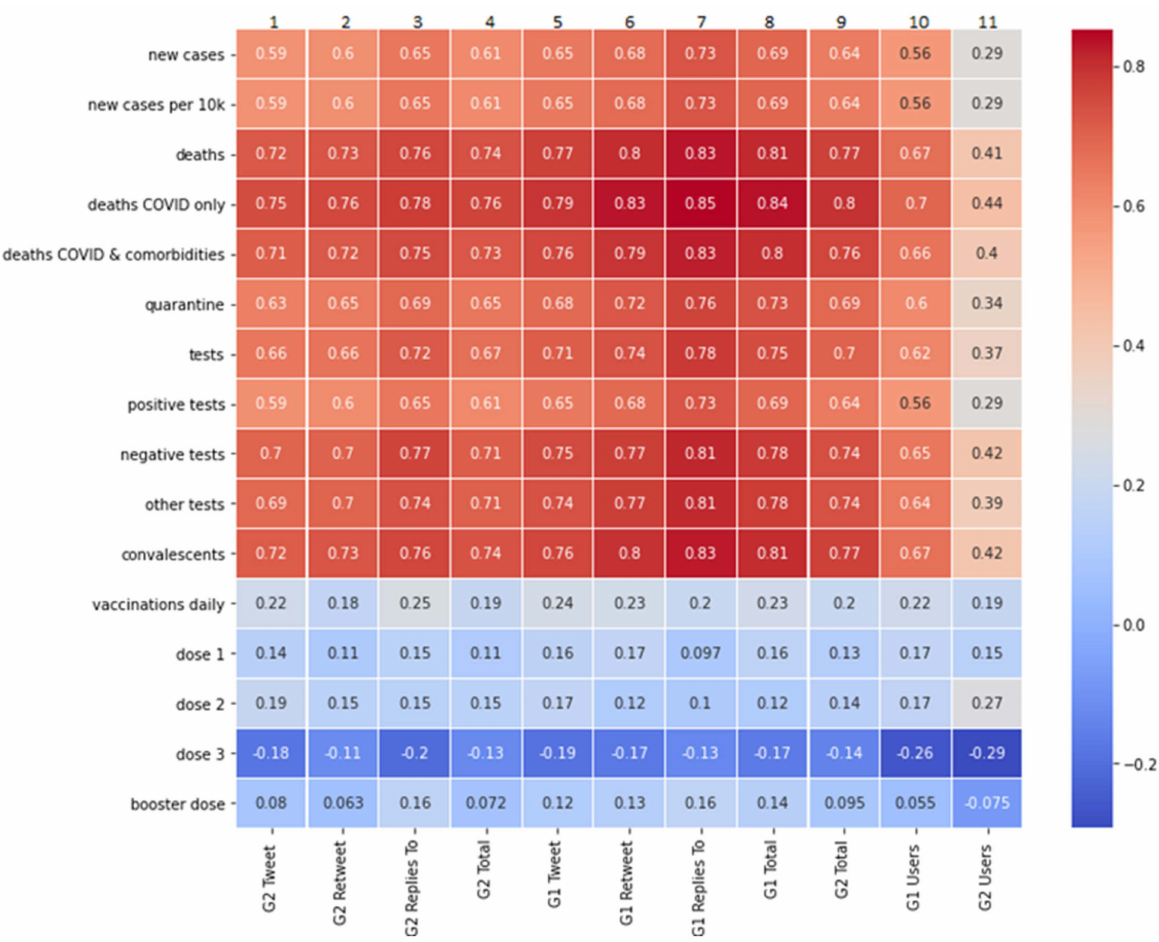
Figure 4. The measures of Pearson’s linear correlation between the COVID-19 epidemiological data and the number of tweets, retweets, and replies published in groups G1 and G2, as well as the size of the groups (labelled “GR1 Users” for the size of G1, and “GR2 Users” for the size of G2). The number of published tweets, retweets, and replies in both groups is strongly correlated with most epidemiological data, except for the vaccinations daily